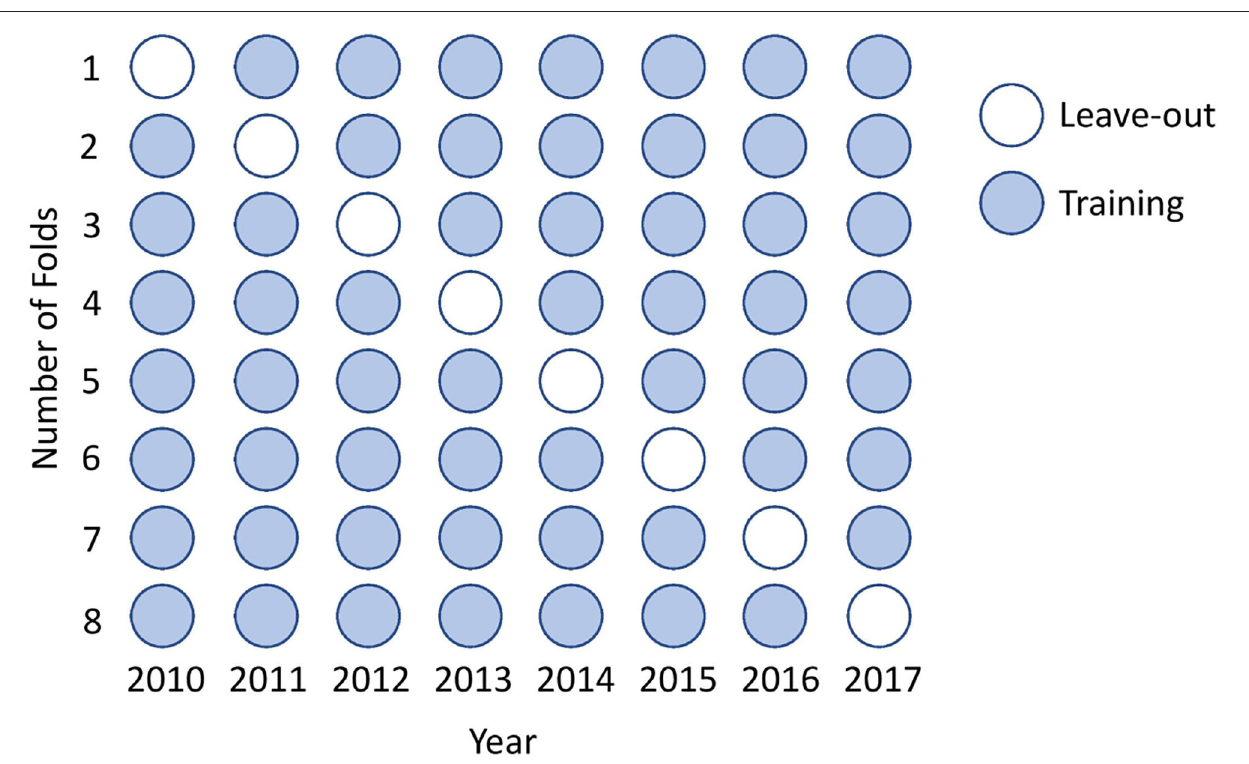
FIGURE 7 | The cross-validation is performed by leaving 1-year out instead of randomly sampling the dataset.